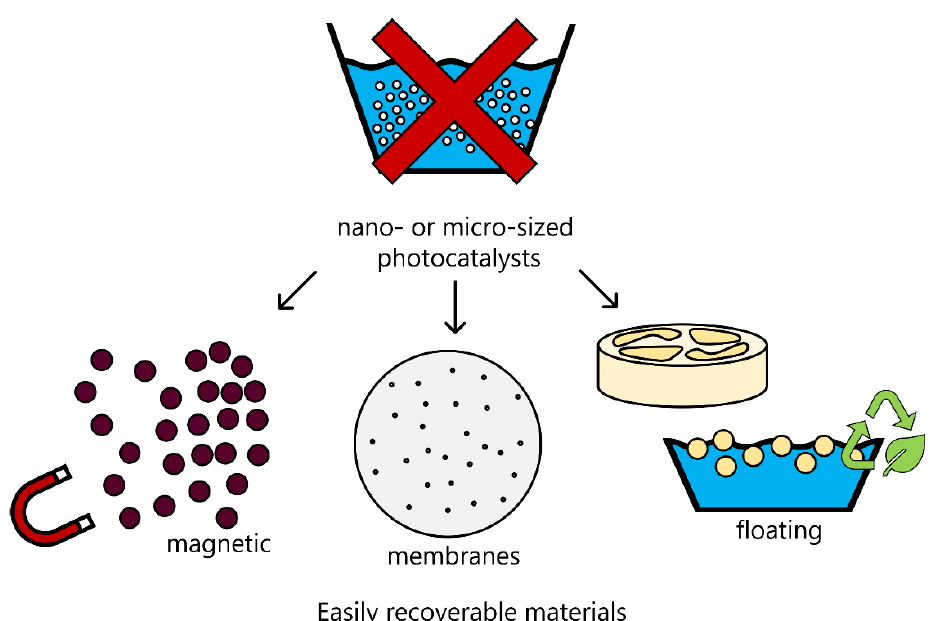
Figure 5. Proposed eco-friendly alternatives to nano- or micro-sized photocatalysts to treat OMWW.